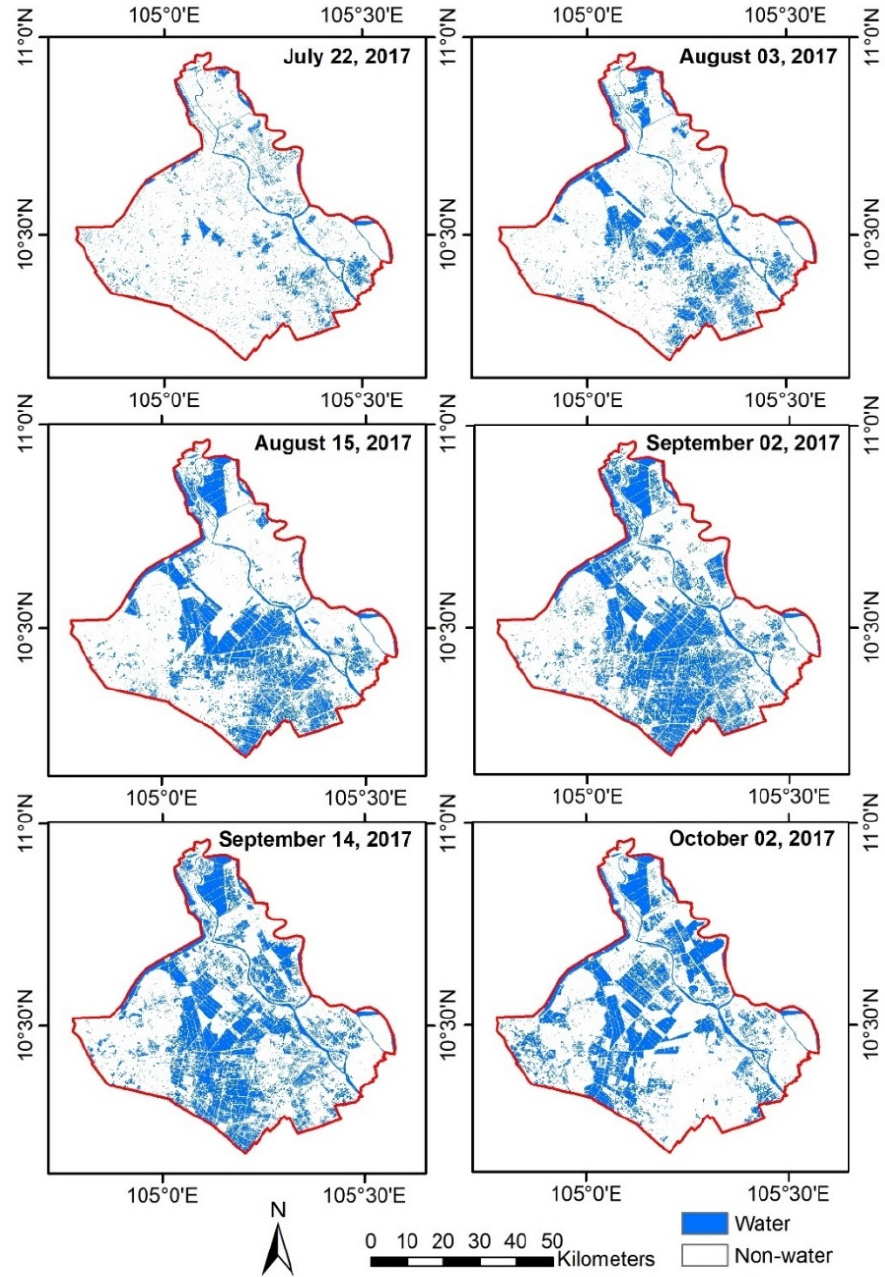
Figure 9. Surface water maps during the flood event in 2017 were derived from using the dynamic Otsu thresholding algorithm on the Sentinel-1 SAR time series.